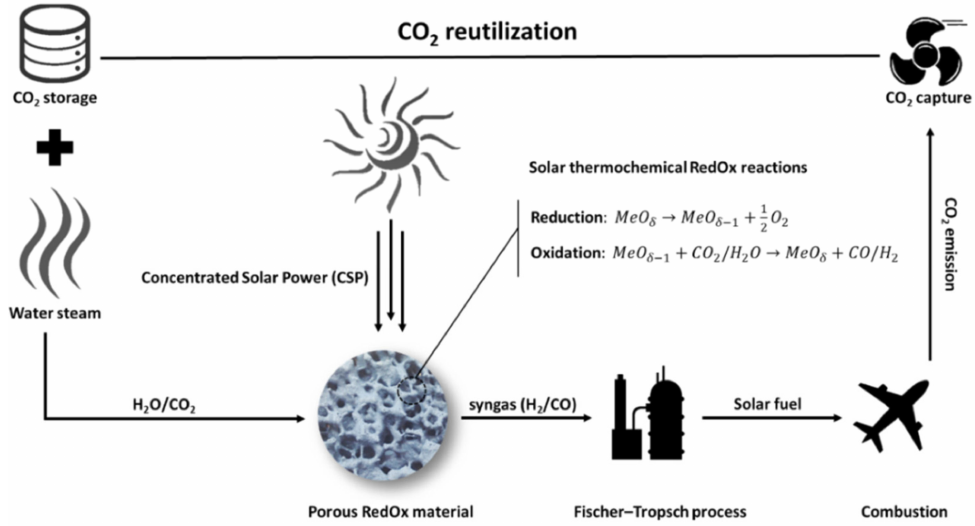
Figure 3. The CDR process via H 2 O/CO 2 -splitting solar thermochemical cycle as a route for solar